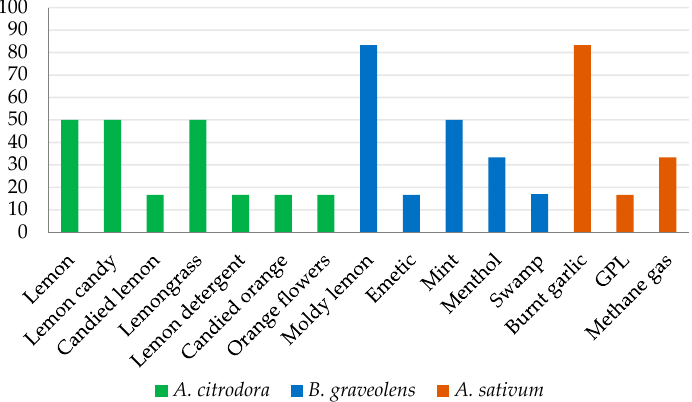
Figure 2. Specific olfactory descriptors and the percentage of times they were used by the expert panel ( n = 8) for characterising the odours of Aloysia citrodora, Bursera graveolens , and Allium sativum essential oils